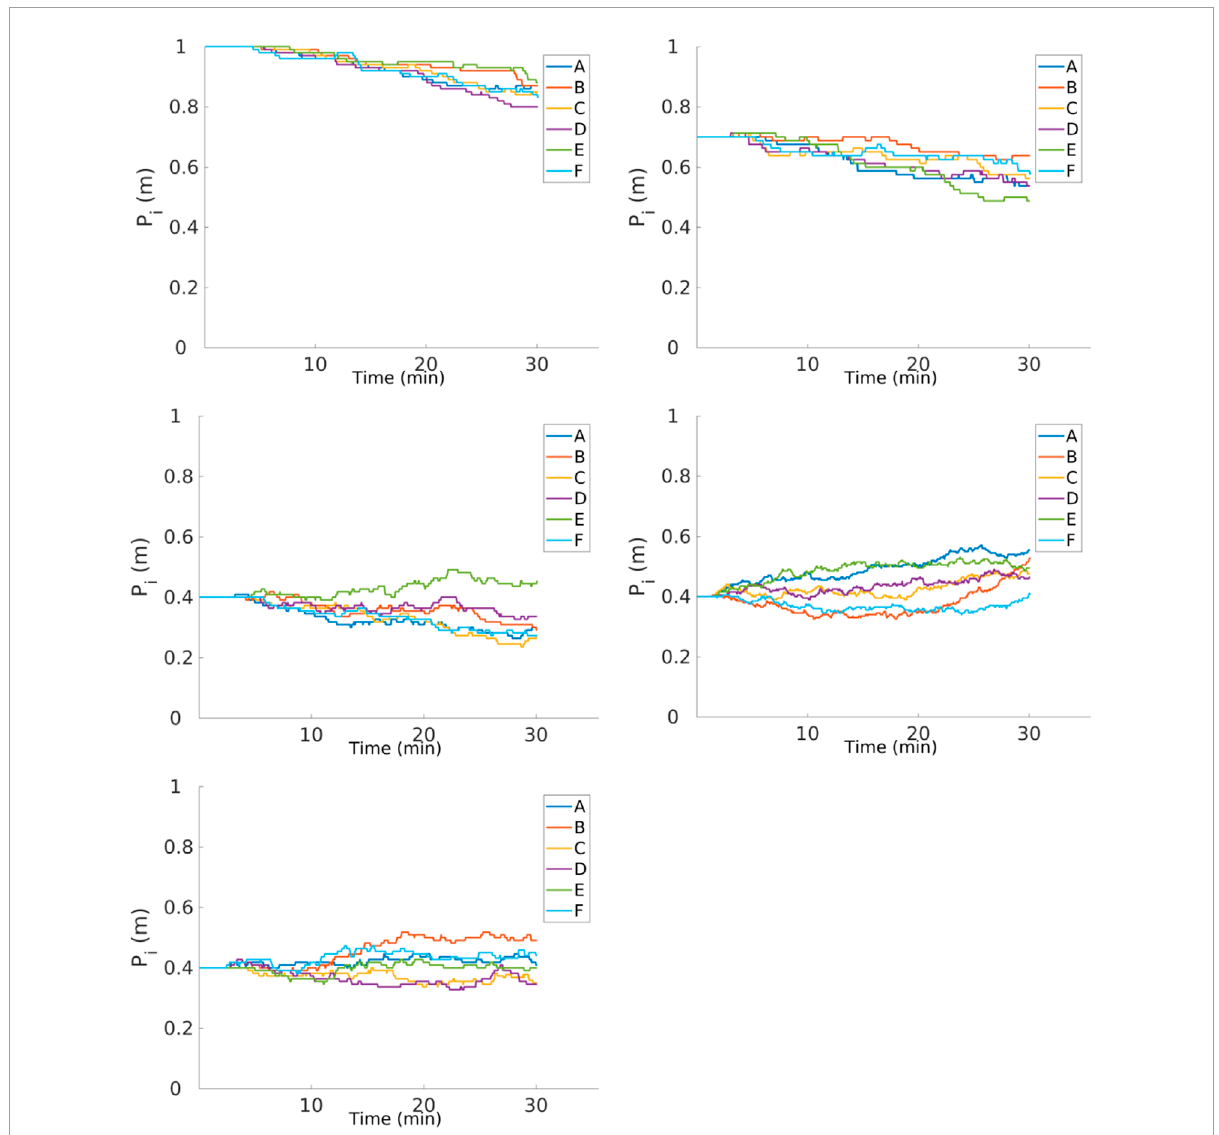
FIGURE 20 Convergence of P i for different P 0 of 1.0 (top left), 0.7 (top right), and 0.4 m (middle left) for an arena of 2.1 m × 1.1 m. Convergence for arenas i 1.0 m × 1.3 m (middle right) and 2.4 m × 1.6 m (bottom left) for P 0 of 0.4 are also shown. The convergence changes from robot to robot and is due i to the error and velocity of the robot.